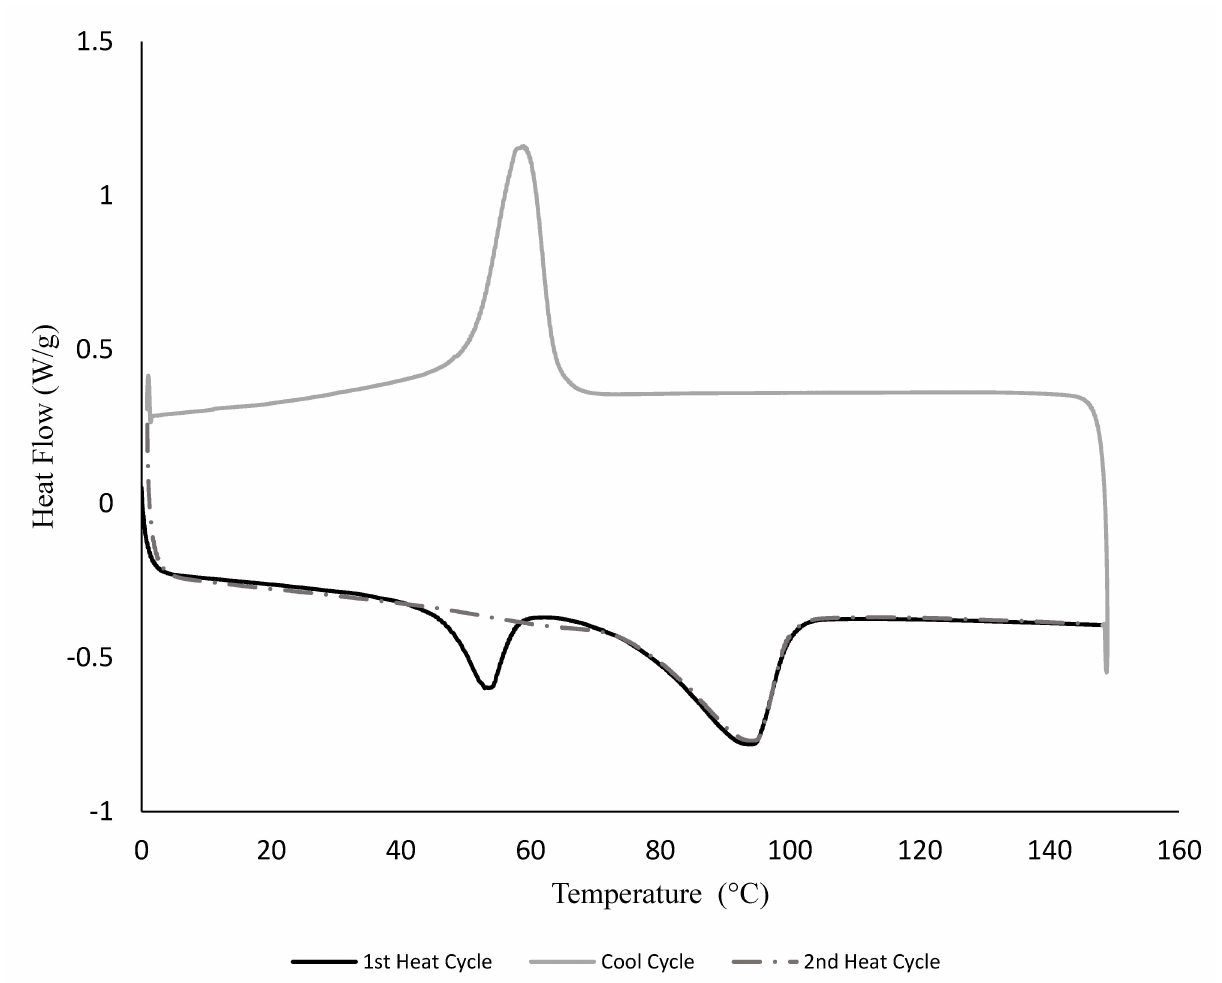
Figure 4. A DSC thermogram for a PEMAA-53%Li-M122 during a heat-cool-heat cycle at a rate of 5 ◦